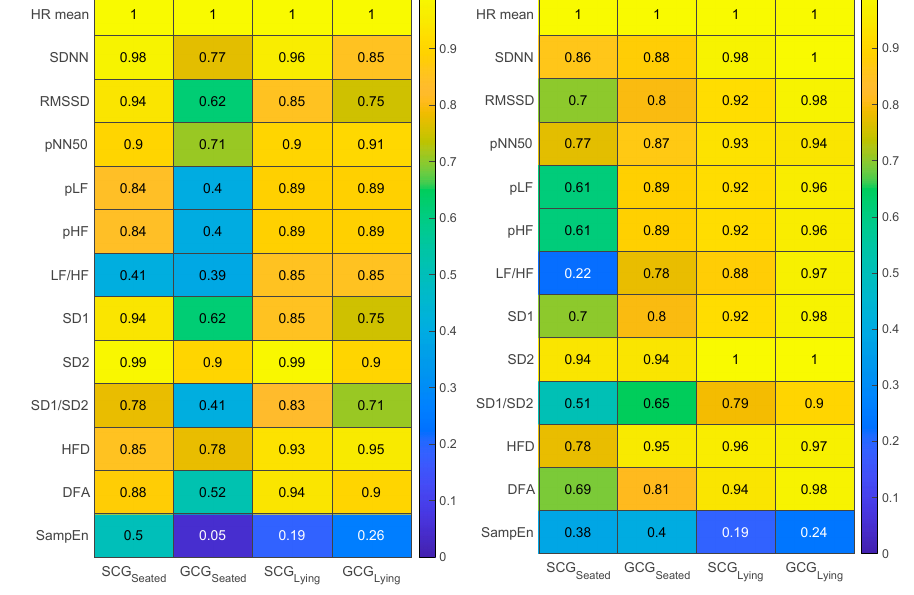
Figure 6. R values (between 0 and 1) obtained in the correlation analysis carried out between values retrieve from SCG and GCG against reference ECG values in both seated and lying position, for both the algorithms.